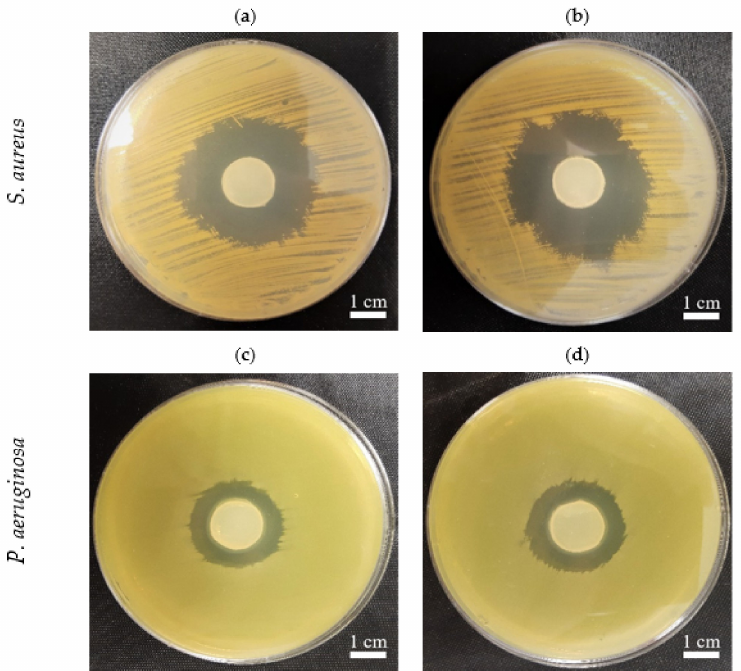
Figure 9. The growth inhibition zones in S. aureus (ATCC 6538) and P. aeruginosa (ATCC 15442) cul- tures, incubated with BC samples from K. xylinus ATCC 53524 soaked with an octenidine-containing antiseptic: ( a , c ) HS-BC; ( b , d ) PJ-BC. The comparable sizes of growth inhibition zones are seen with regard to specific pathogens independently from the type (PJ, HS-BC) of cellulose in which the sorption of octenidine was